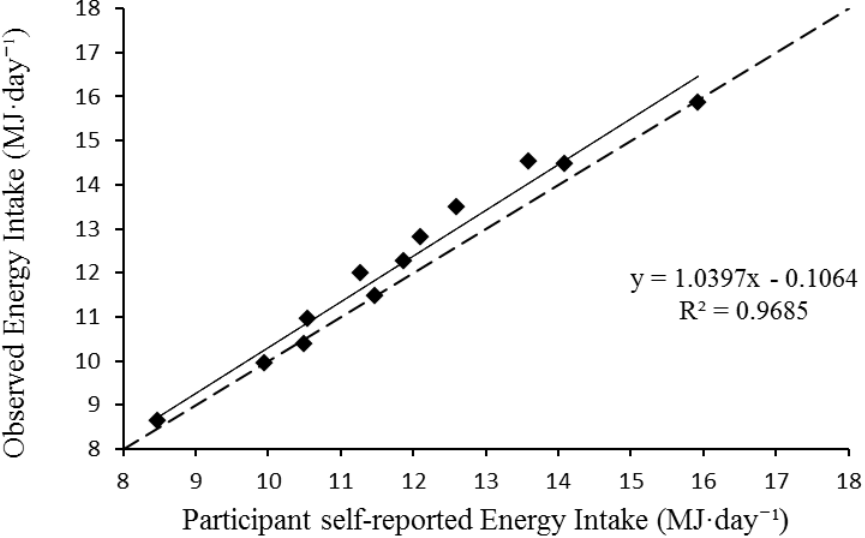
Figure 2. Linear regression scatter plot. The dashed line represents the line of equality. The solid line denotes the regression line.